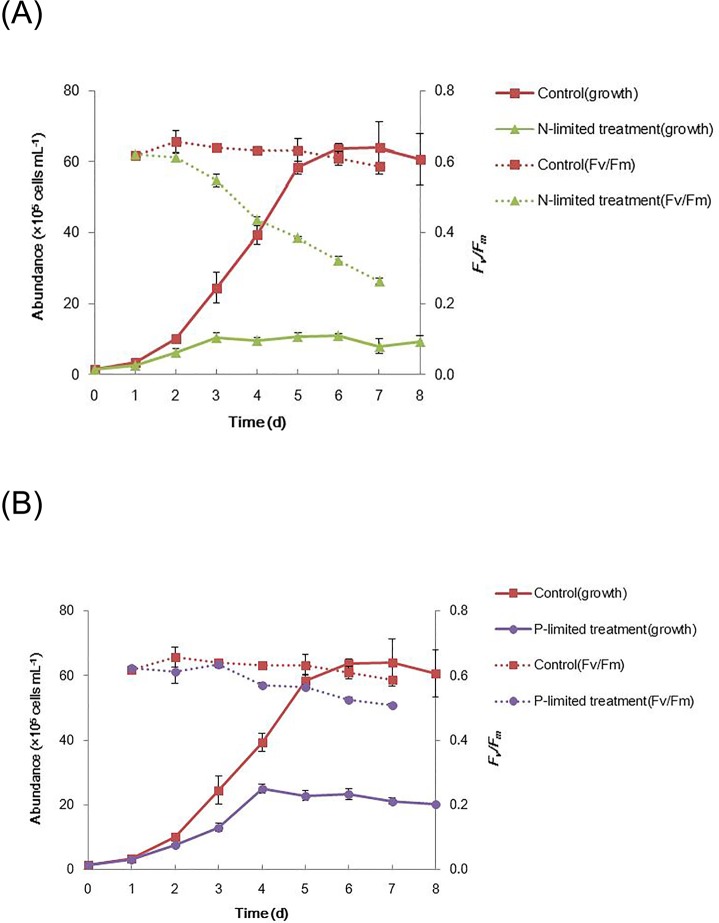
Cell growth (abundance, left vertical axis) and photosynthetic efficiency (Fv/Fm, right vertical axis) of N-limited (A) and P-limited (B) T. pseudonana cultures (mean ± SD of triplicate measurements).